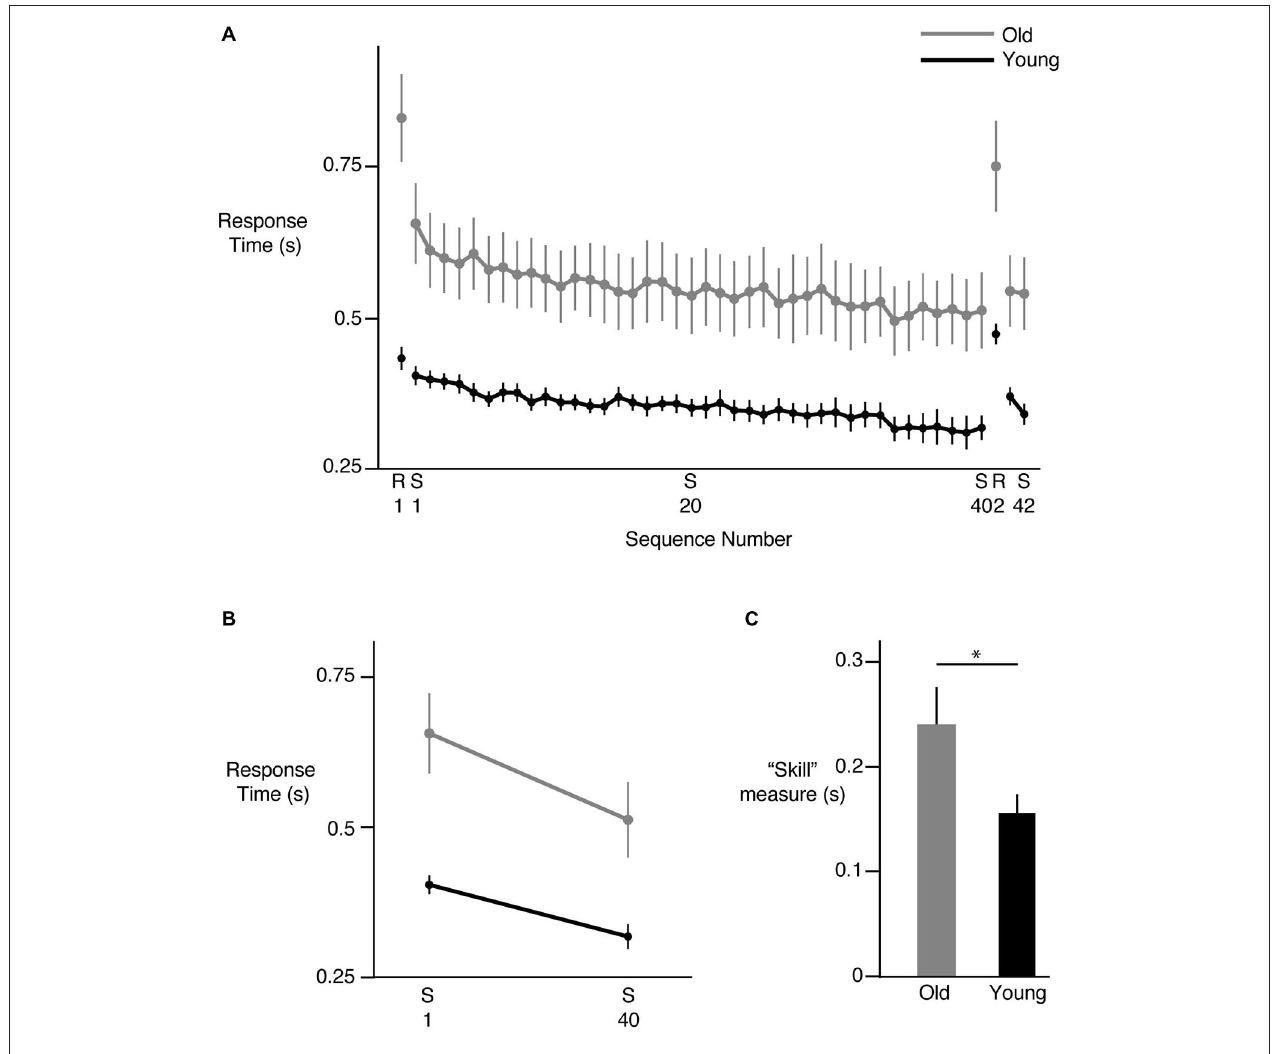
S40, then increased on presentation of R2, and then decreased again on S41 and S42, indicating development of sequence specific learning. (B) Net change in response time from S1 to S40 in the two groups. The magnitude of change was greater in the old group. (C) Difference in sequence specific “skill” learning between the old (gray) and young (black) groups. All data shown are Mean ± SE. * = statistically